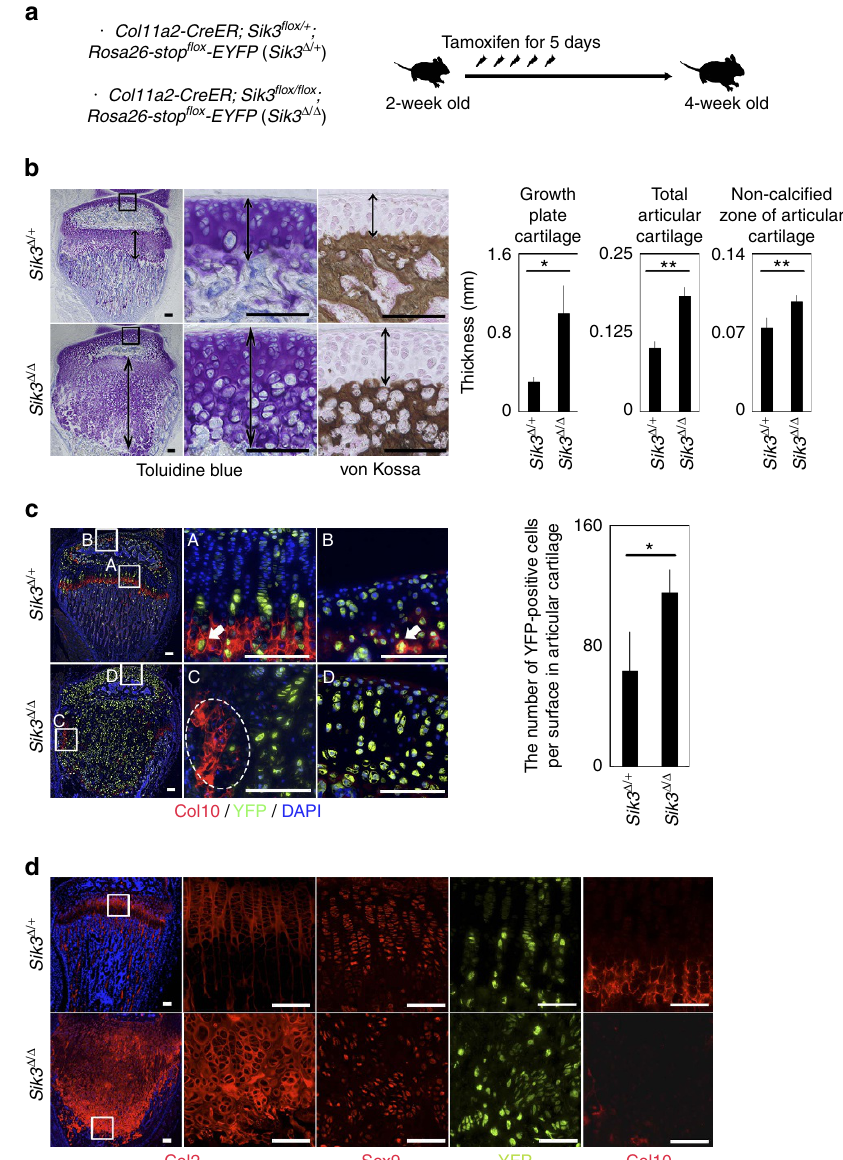
Figure 1 | Phenotype of cartilage in mice lacking Sik3 after birth. ( a ) We injected Col11a2-CreER; Sik3 flox/flox ; Rosa26-stop flox -EYFP mice and Col11a2-CreER; Sik3 flox/ þ ; Rosa26-stop flox -EYFP mice with tamoxifen daily for 5 consecutive days beginning at 2 weeks of age and killed them at 4 weeks of age. ( b ) Semiserial histological sagittal sections of proximal tibia stained with toluidine blue and von Kossa. Boxed regions are shown to the right. Thickness of growth plate cartilage, total articular cartilage and non-calcified articular cartilage at the vertex of the articular surface in the corresponding sections of the weight-bearing area (indicated by arrows) were measured and are shown in the right graphs. n ¼ 4 mice. ( c ) Semiserial sections of b were immunostained for Col10 (red) and YFP (yellow). Blue colour is DAPI. Boxed regions indicated by A–D are shown to the right. The numbers of EYFP-positive cells per 360 m m-surface in articular cartilage were counted and are shown in the right graph. Arrows , Col11a2 -marked YFP-positive chondrocytes in Col10-positive matrix in Sik3 D / þ mice. Dotted circle , the Col10-positive area lacking YFP-positive cells in Sik3 D / D mice; n ¼ 4 mice. ( d ) Semiserial sections of b , c were immunostained for Col2, Sox9, YFP and Col10. Boxed regions in the left panels (Col2) are shown in the right panels. The images are representative of two independent experiments. Error bars denote means ± s.d. * P o 0.05 and ** P o 0.01 by the t -test. Scale bars, 100 m Sik3 deletion protects cartilage from osteoarthritis . We next (Fig. 1cC, dotted circle), suggesting that progenies of Sik3 D / D chondrocytes continued to express Col2 instead. We confirmed examined whether Sik3 deletion affected the development of that Sik3-deficient cells expressed Col2 and Sox9, but not Col10 osteoarthritis in adult mice. We treated 7-week-old mice with in growth plate cartilage (Fig. 1d, bottom panels), indicating tamoxifen to prepare Sik3 D / D and Sik3 f/f mice, and subsequently subjected their right knees to destabilized medial meniscus that Sik3-deficient cells remain chondrocytes. These results (DMM) surgery or sham surgery (skin and joint capsule incision) collectively suggest that Sik3 deletion keeps the Col2-positive; at 8 weeks of age. The mice were killed 8 weeks after the operation Col10-negative chondrocyte state, which increases the population (therefore at 16 weeks of age) and subjected to histological of Col2-positive; Col10-negative chondrocytes and thickening of analysis (Fig. 2a). The thickness of articular cartilage in articular cartilage.